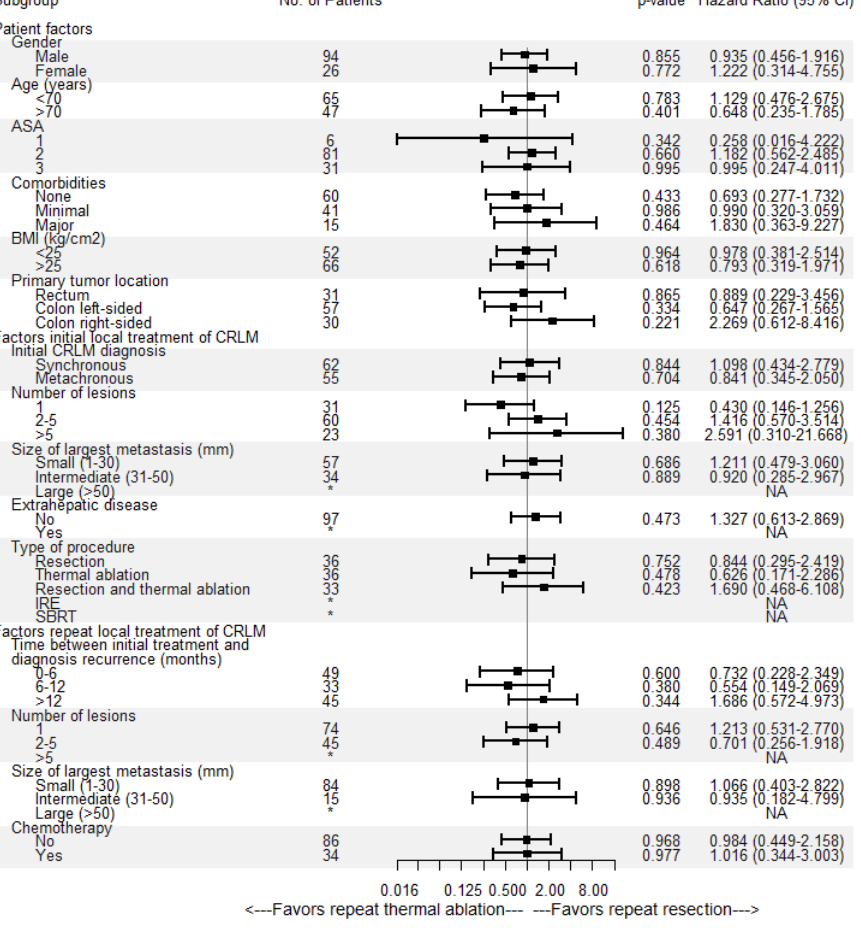
Figure 5. Univariable subgroup Cox regression analyses of repeat resection versus repeat thermal ablation associated with overall survival (OS). No = number, CI = confidence interval, ASA = American Society of Anesthesiologists score, BMI = body mass index, * = insufficient subgroup size for each treatment group, NA = not